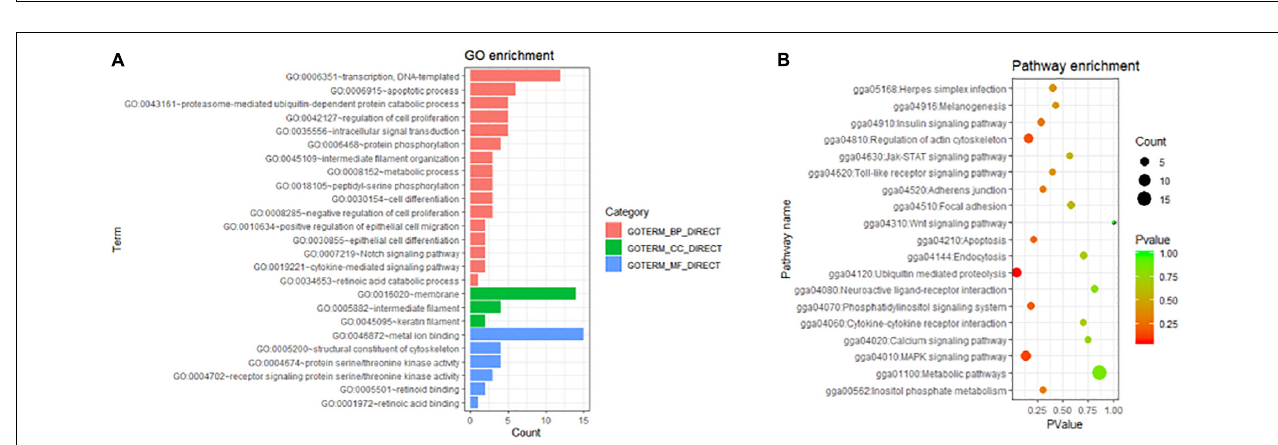
FIGURE 4 | The GO (A) and KEGG (B) enrichments with differentially expressed genes between early-feathering and late-feathering Shouguang